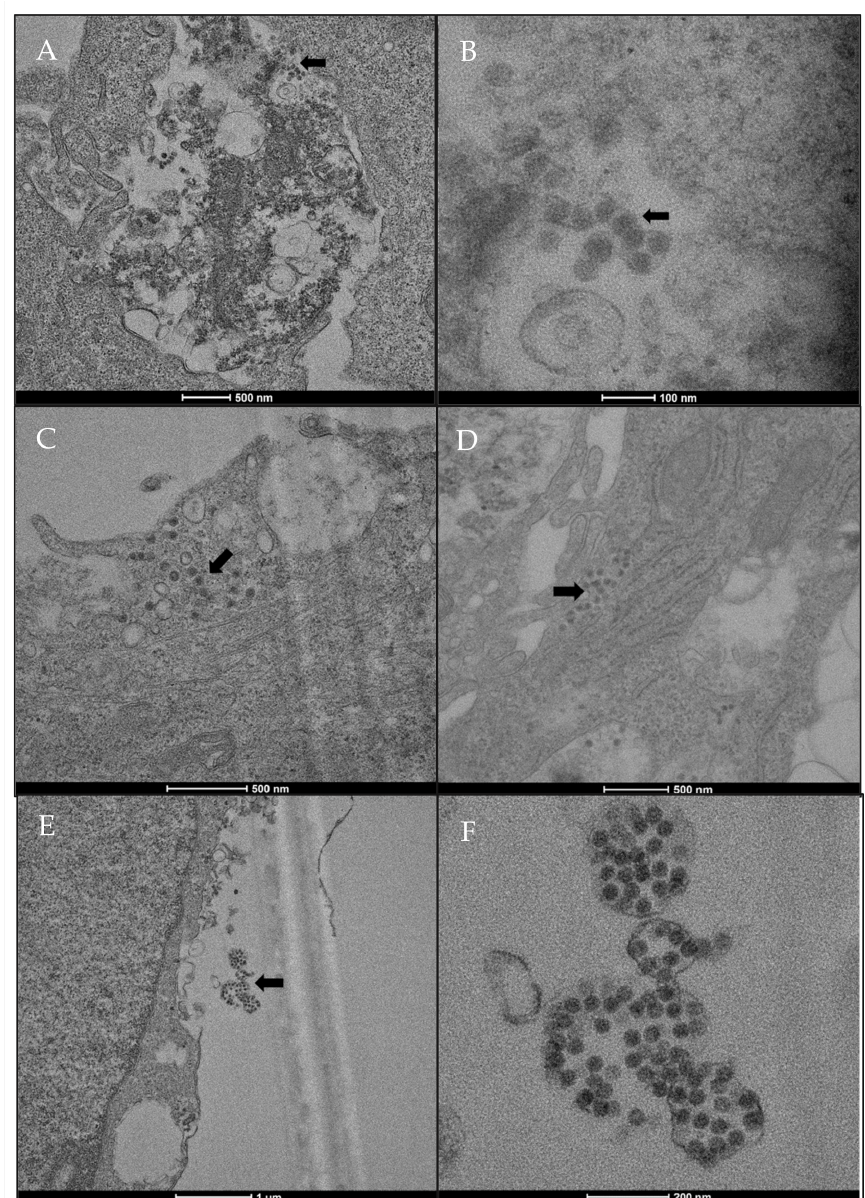
Figure 4. Localization of SARS-CoV-2 in HMEC-1 cell line, analyzed by TEM. ( A ) HMEC-1 presenting SARS-CoV-2 infection (arrow) and a severe degeneration (scale bar: 500 nm). ( B ) Enlargement of previous figure, showing spherical viral electron-dense particles within vacuoles (scale bar: 100 nm). ( C ) Spherical viral particles located in the cytosol (scale bar: 500 nm). ( D ) Spherical viral particles located in the cytosol, near the RER. ( E ) Aggregate of spherical viral particles outside the cells (scale bar: 1 µ m). ( F ) Enlargement of panel ( E ), showing spherical viral particles, containing black dots on the inside, within structures with smooth membrane (scale bar: 200